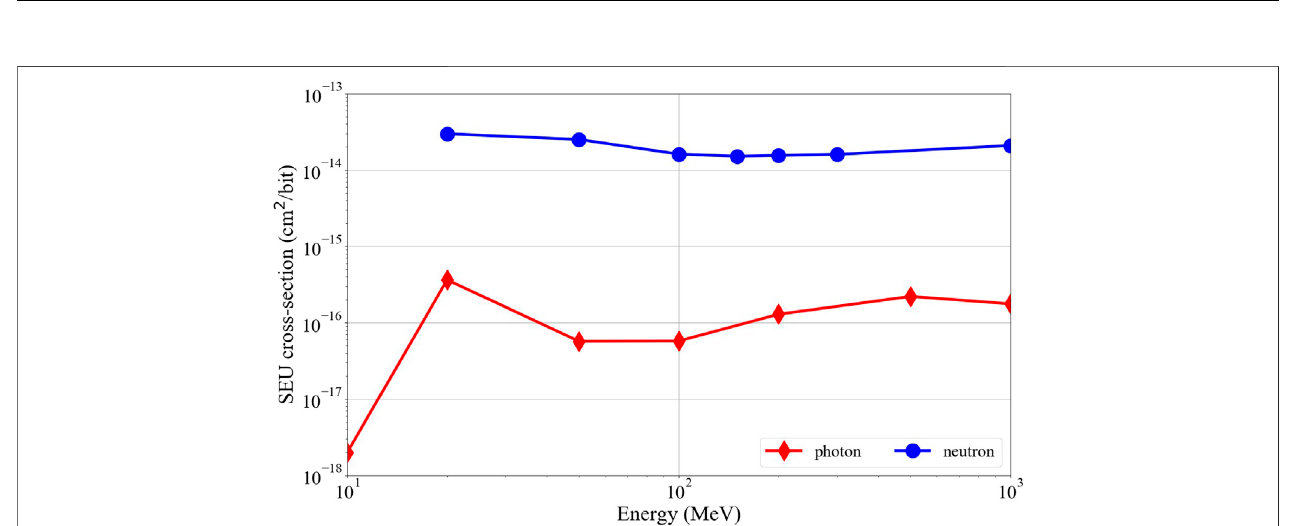
FIGURE 11 | Simulated photon and neutron SEU cross section for 40 nm commercial